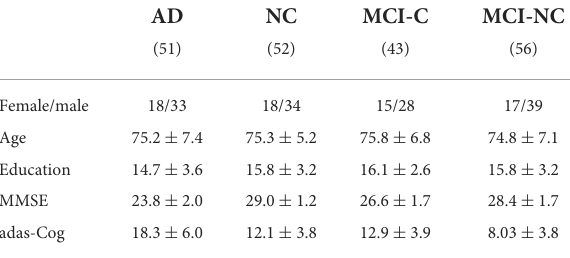
TABLE 1 Demographic information of the